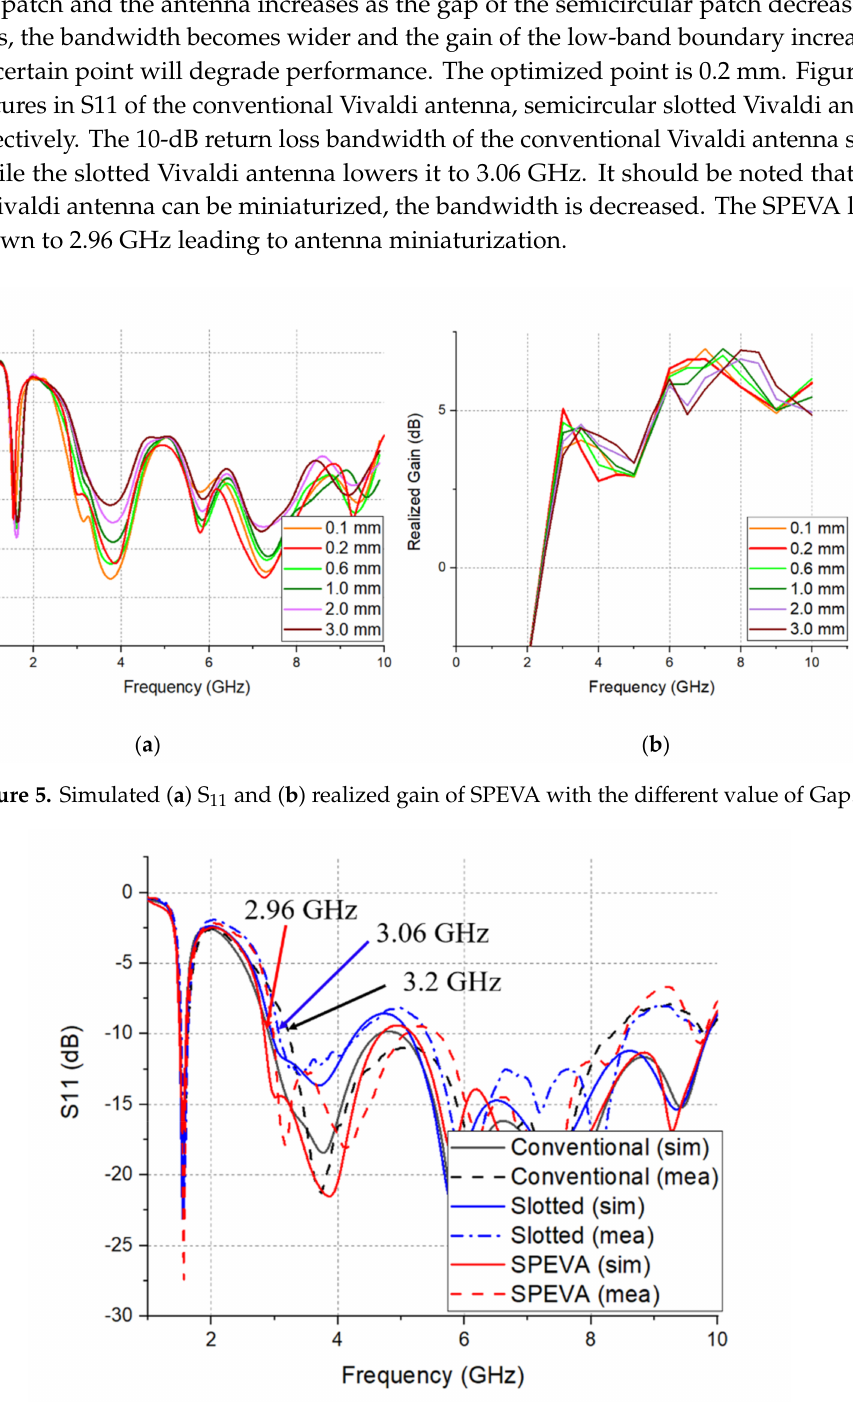
Figure 6. Simulated and measured S 11 of three types of Vivaldi